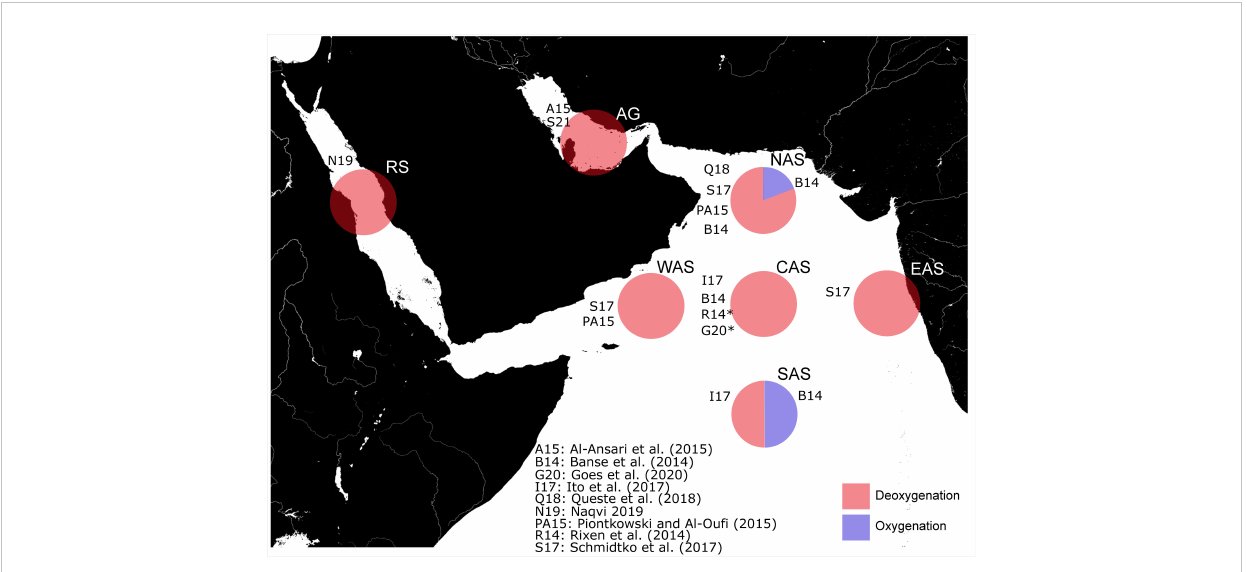
FIGURE 3 Observational studies reporting recent O 2 changes in the Arabian Sea. Observational studies documenting recent O 2 trends in the northern (NAS), central (CAS), southern (SAS), eastern (EAS) and western (WAS) Arabian Sea, as well as in the Arabian Gulf (AG) and Red Sea (RS). In each subregion, the proportion of studies suggesting deoxygenation (red) vs. oxygenation (blue) is indicated with a pie chart. Deoxygenation trends in studies labeled with (*) are inferred from relevant proxy data and are not based on direct measurements of